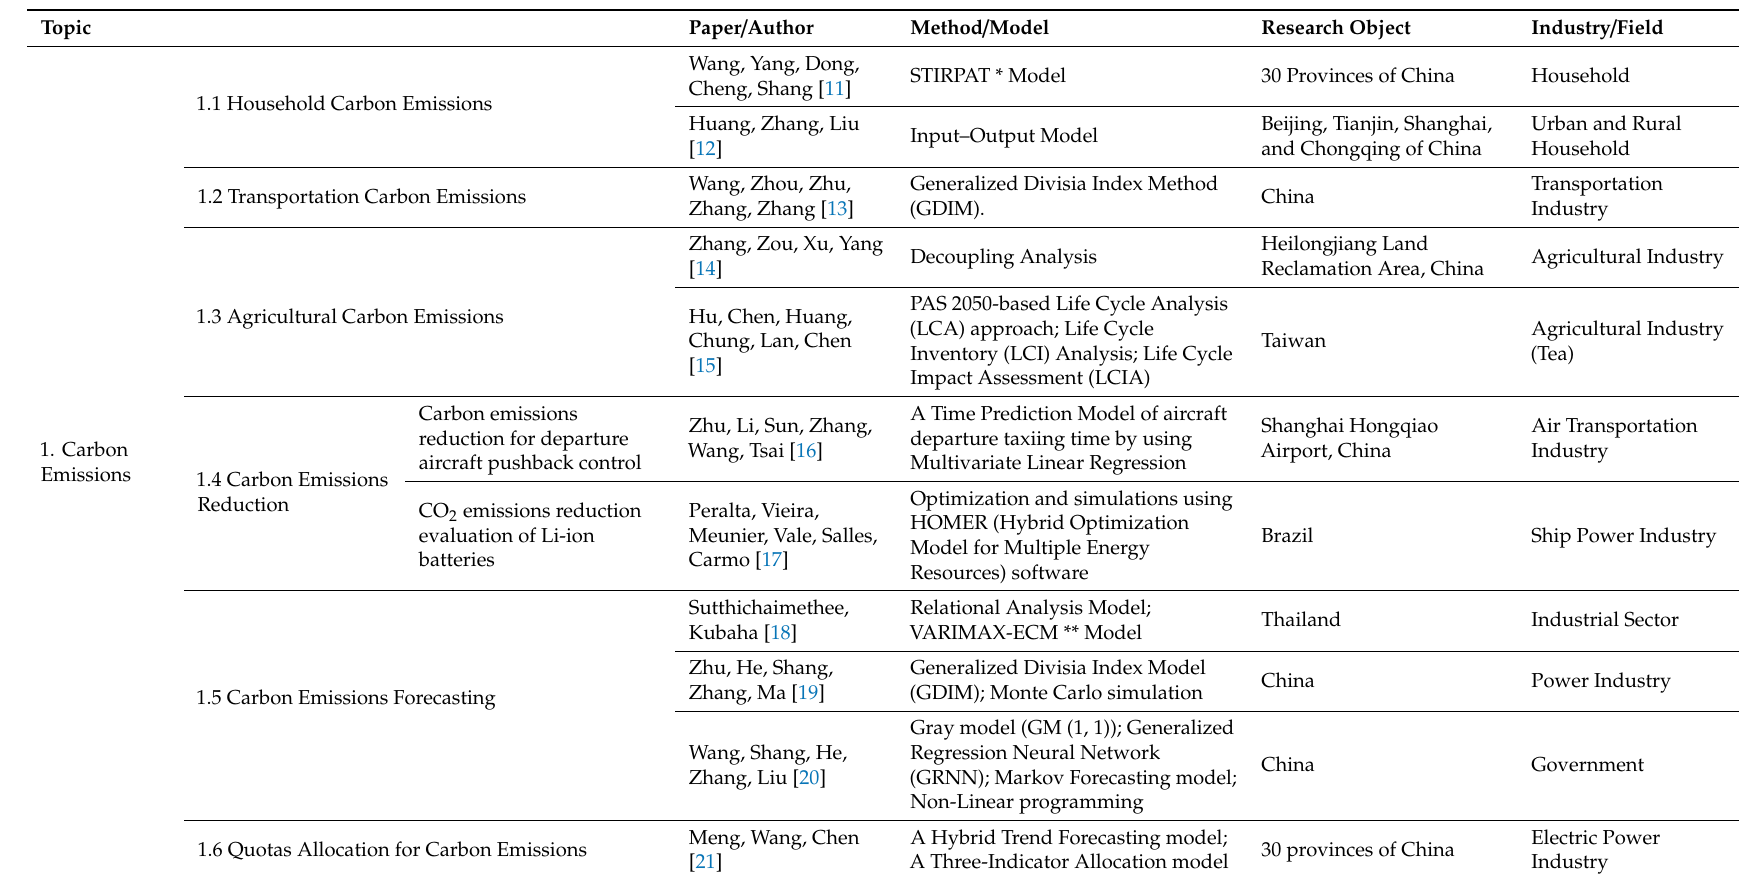
Table 1. Summary information of 20 papers in this special